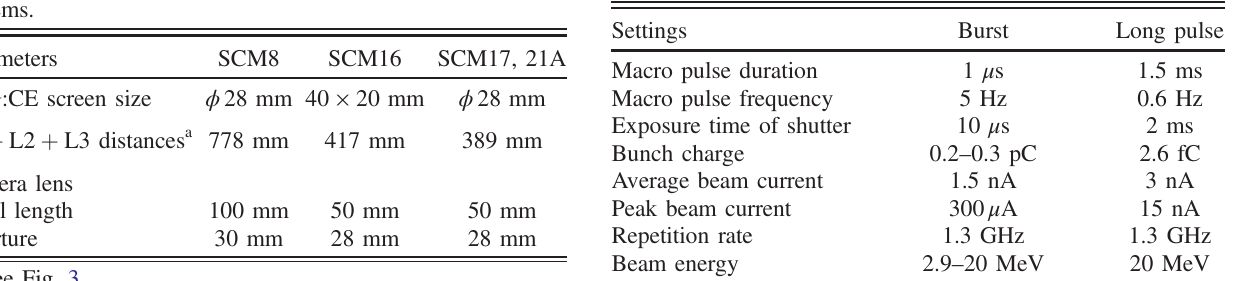
TABLE III. Settings for beam halo